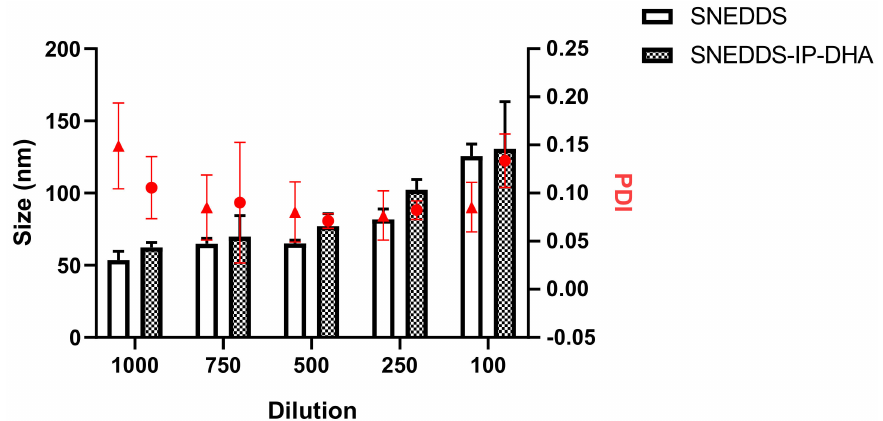
Figure 5. Mean size and PDI of empty NE and NE-IP-DHA as a function of water dilution of SNEDDS and SNEDDS-IP-DHA at 30 mg/Ml. The columns represent the mean size (nm) and the red circles or triangles the PDI. ( n =